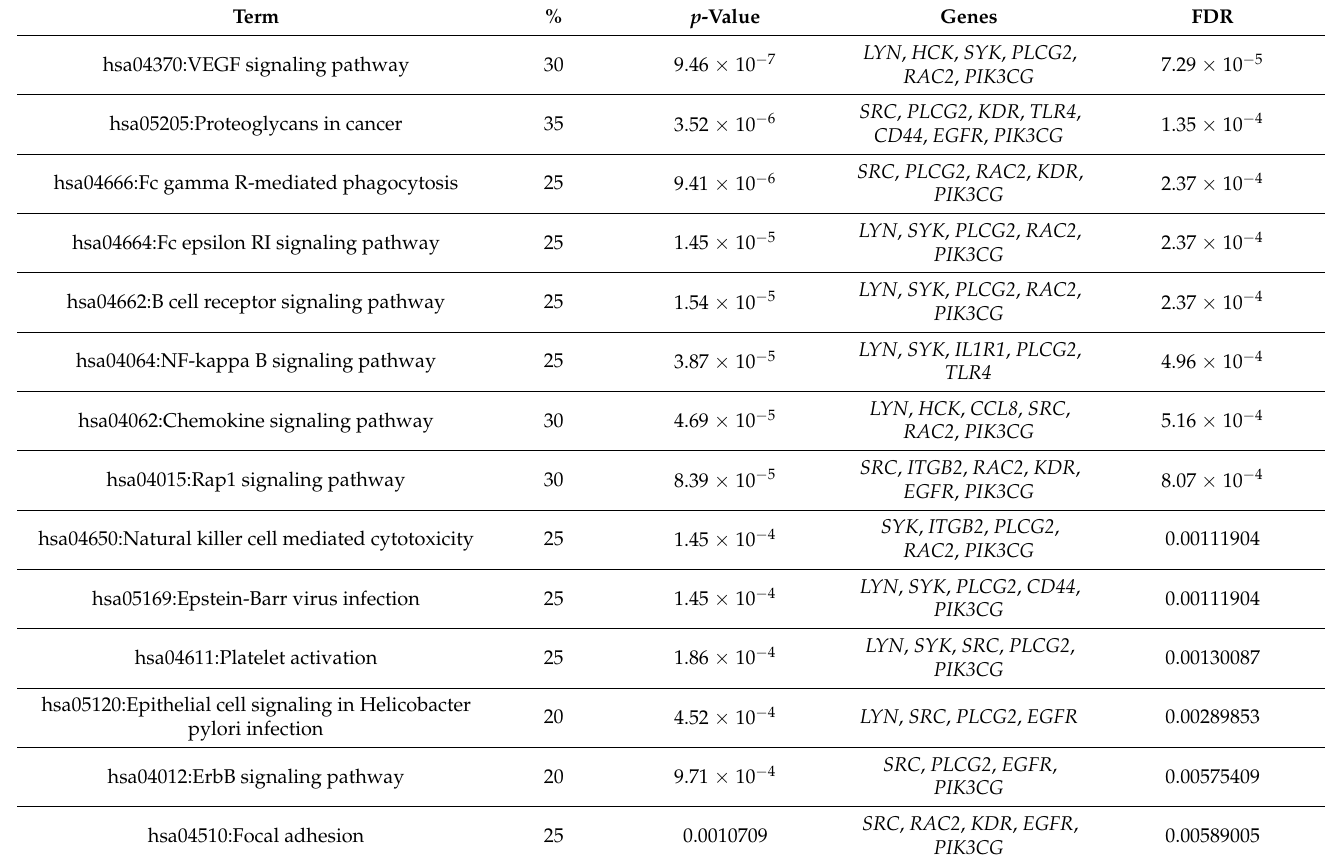
Table 4. The KEGG pathways of the top 20 candidate hub genes of PPI network in GBM gene expression dataset.